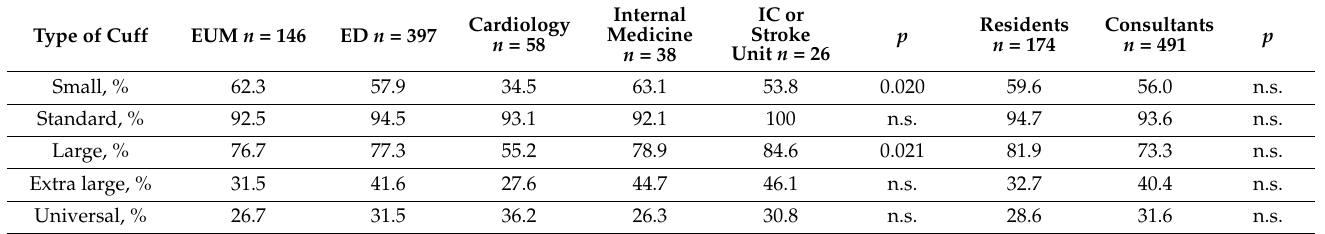
Table 3. Availability of different sizes of cuffs for correct detection of office BP by department and qualification